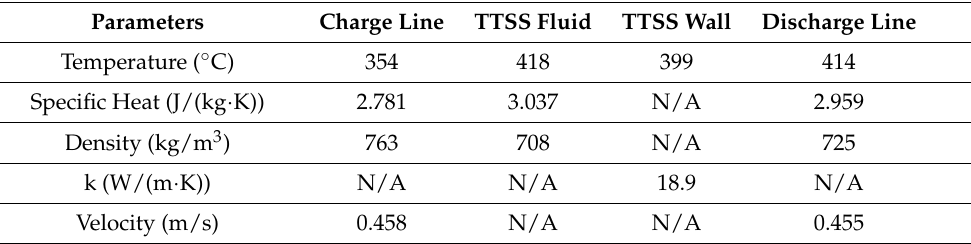
Table 3. Accelerated nominal values used to non-dimensionalize the extrapolated data. N/A indicates that the value was either not measured or not applicable.